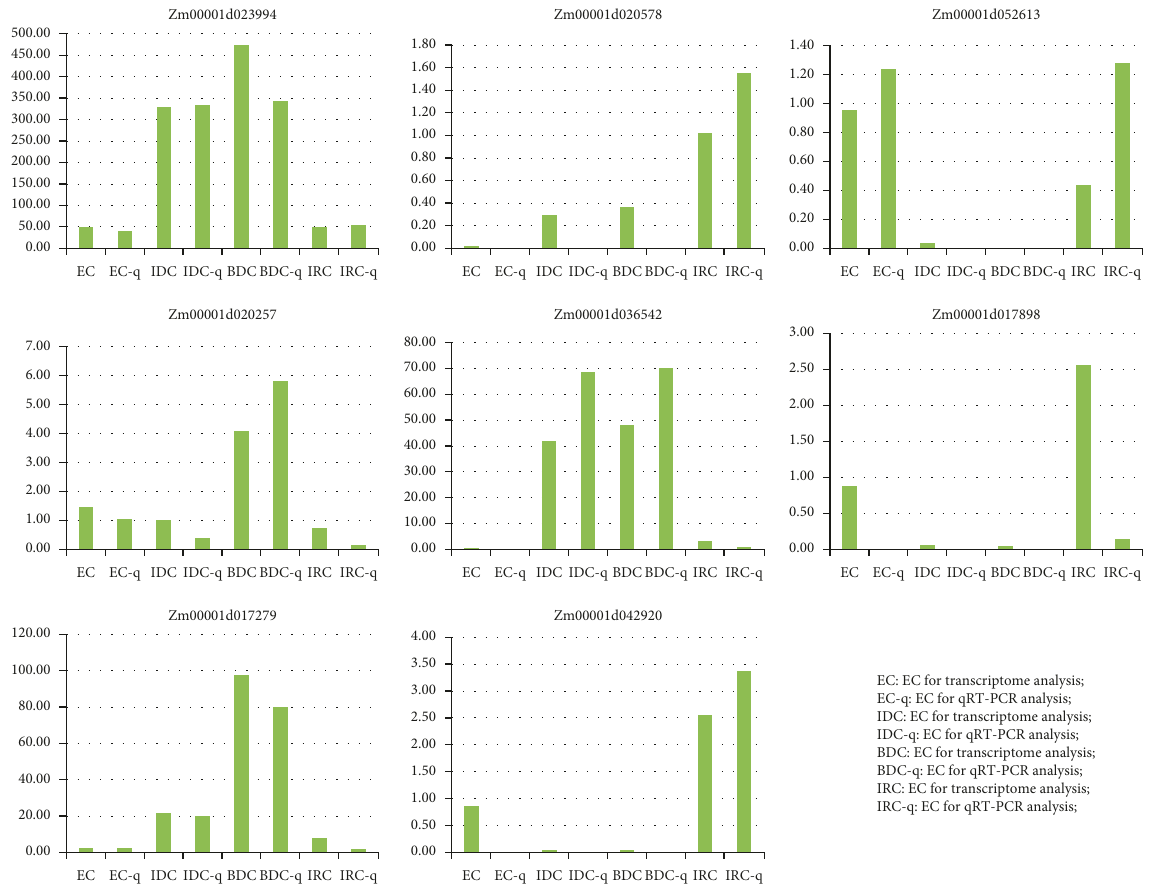
Figure 7: Expression profiles of DEGs selected based on the transcriptome analysis. qRT-PCR. EC, IDC, BDC, and IRC represent gene expression levels as a result of transcriptome analysis. EC-q, IDC-q, BDC-q, and IRC-q represent gene expression levels and were identified by qRT-PCR